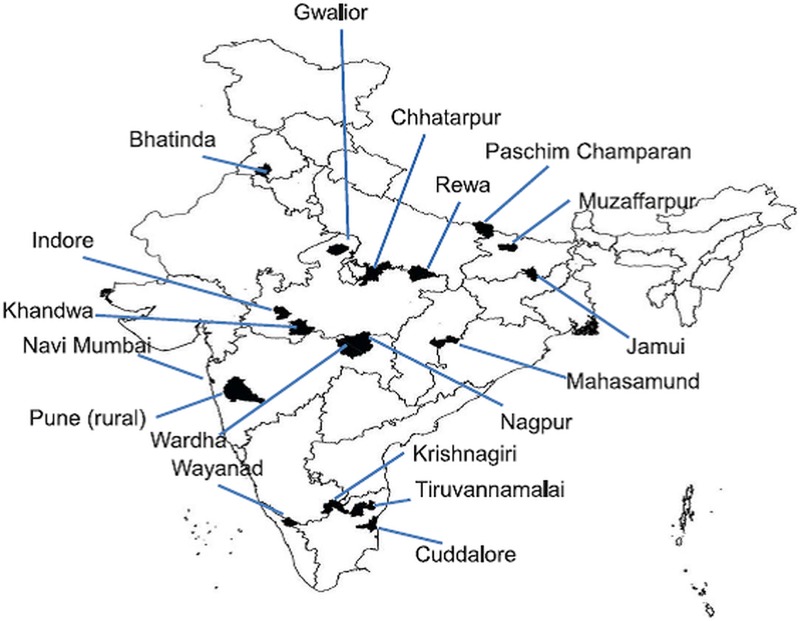
Map of India depicting the randomly sampled Axshya districts (n = 18) under Axshya SAMVAD study, India (2016–17) [24]*.SAMVAD–sensitization and advocacy in marginalised and vulnerable areas of the district. Axshya SAMVAD–an active case finding strategy under project Axshya implemented by The Union, South East Asia office, New Delhi, India, across 285 districts of India. * Reprinted from Shewade HD et al [24] under a CC BY license, with permission from International Union Against Tuberculosis and Lung Disease (The Union), Copyright The Union 2017.